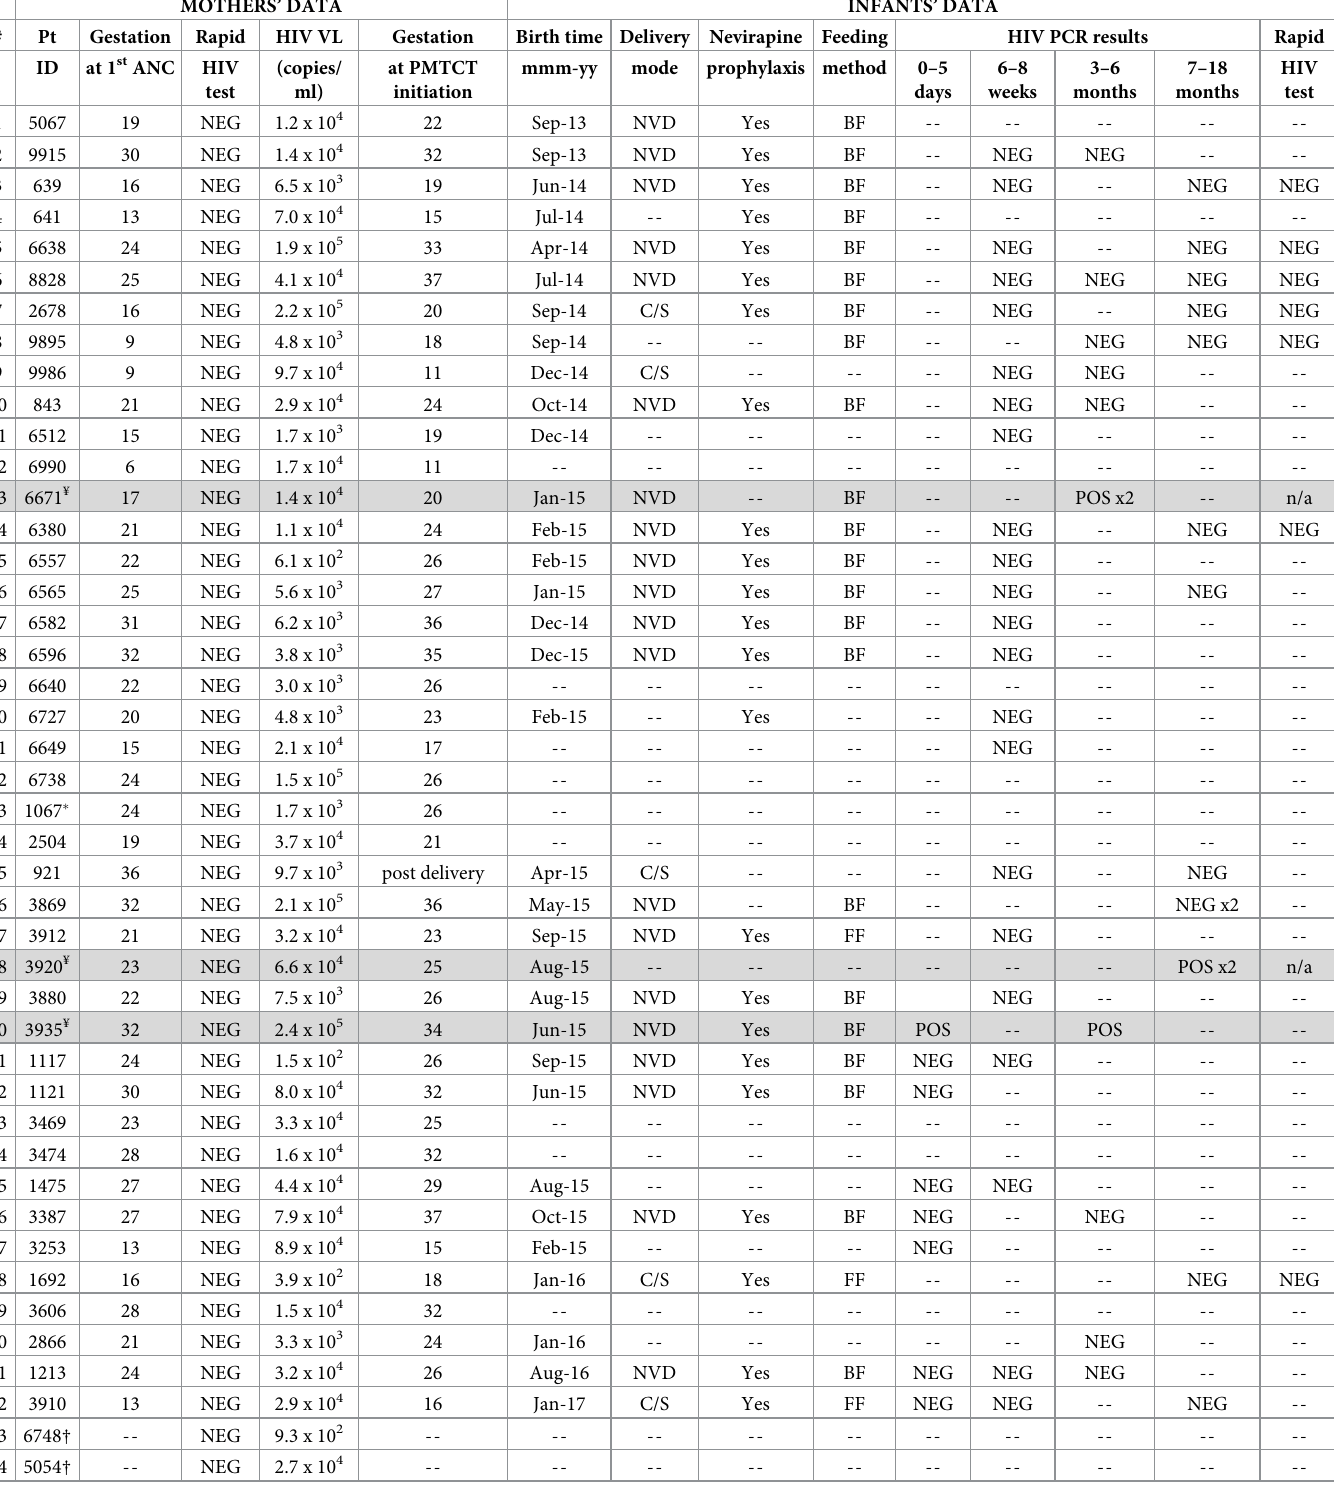
Table 2. Data on antenatal care and assessment of mother-to-child transmission of